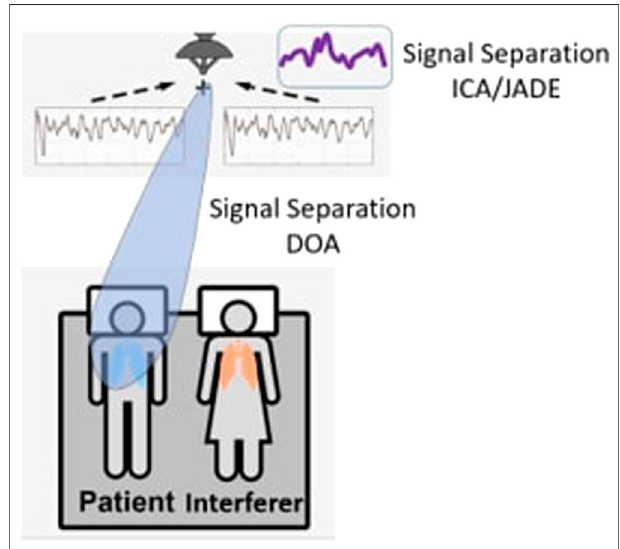
FIGURE 5 | Illustration of challenges of respiration sensing in multi- subject environments. While it is possible to isolate one well-spaced subject ’ s respiratory signature from a combined mixture using direction of arrival (DOA), subjects closer together impose antenna array resolution limitations for DOA. Alternatively, the ICA/JADE algorithm can employ spectral analysis to isolate respiratory signaturesfor subjects in close proximity.